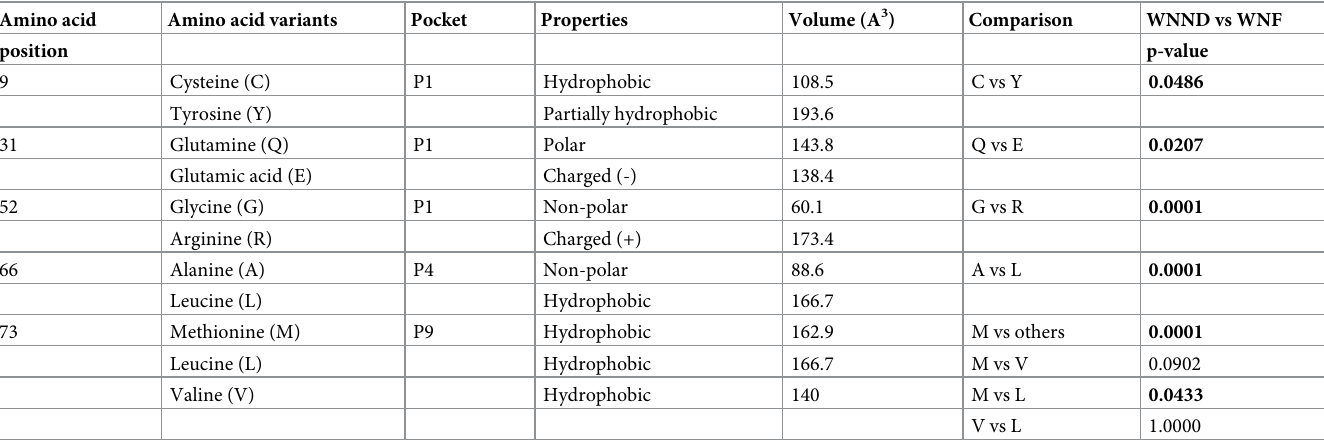
Table 2. List of WNV neuroinvasion-associated amino acid residues in HLA-DQA1 and their properties [25]. P values in bold indicate significance. Amino acid Amino acid